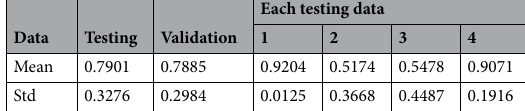
Table 4. The mean and std of loss in original data quantity